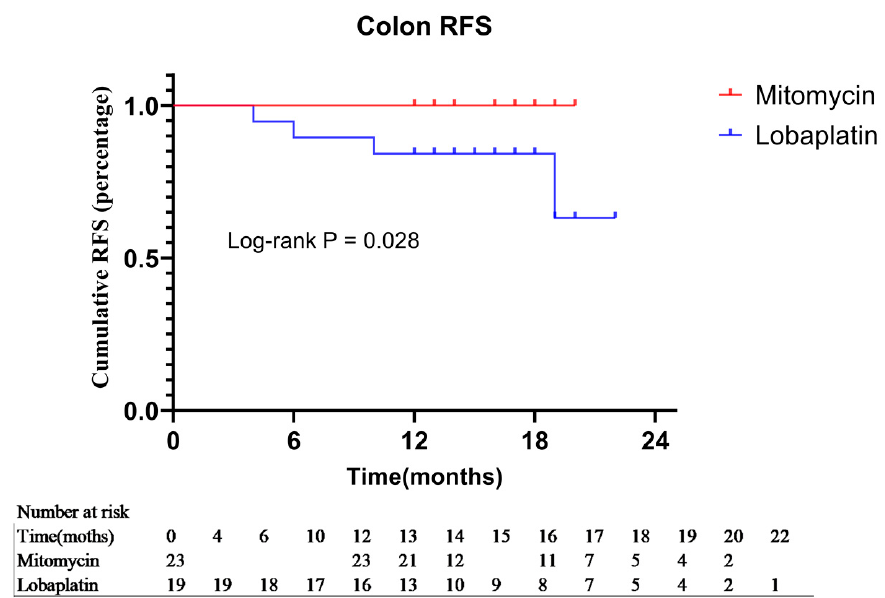
Figure 5. Subgroup analysis based on tumor location. Recurrence-free survival of the Mitomycin group and Lobaplatin group after PSM when the tumor at colon.